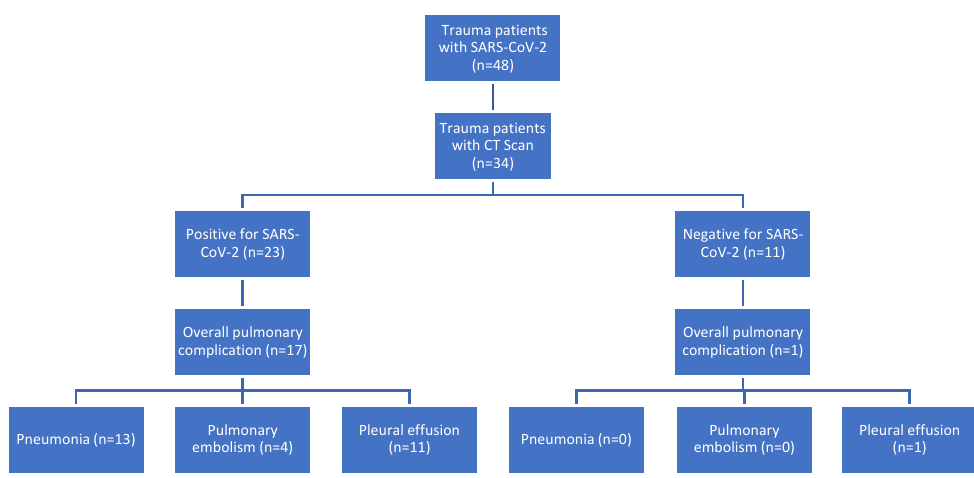
Figure 1. Clinical course for trauma patients with SARS-CoV-2 infection and positive CT findings. Table 2. Clinical course for polytrauma patients with SARS-CoV-2 infection and positive CT findings. CT Findings Positive